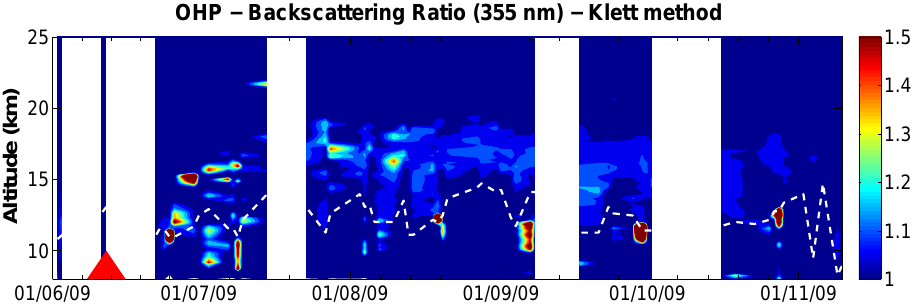
Fig. 6. Aerosol backscatter ratio observed with the 355nm OHP lidar (Observatoire de Haute Provence, France) during the 1 June 2009–10 November 2009 period. The dashed white line is the thermal tropopause. The Sarychev eruption is symbolized by the red triangle.